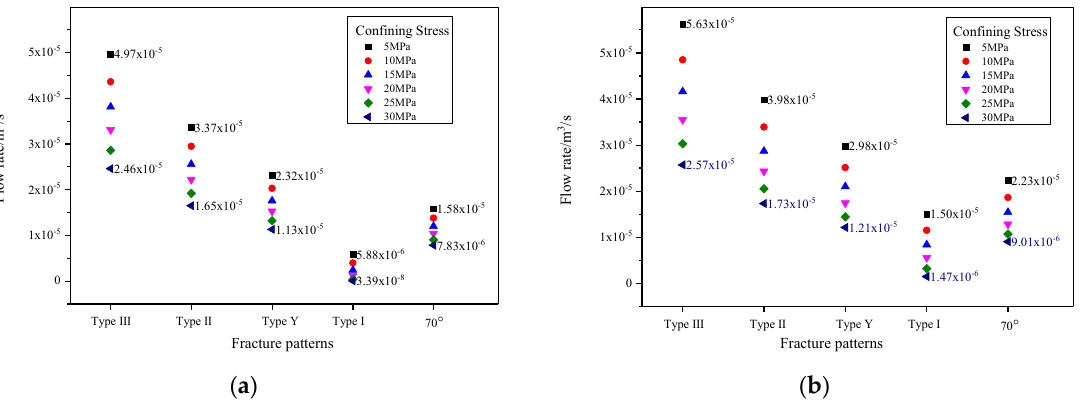
Figure 29. Flow rate change curves of different crack modes: ( a ) axial pressure of 40 MPa and ( b ) axial pressure of 10